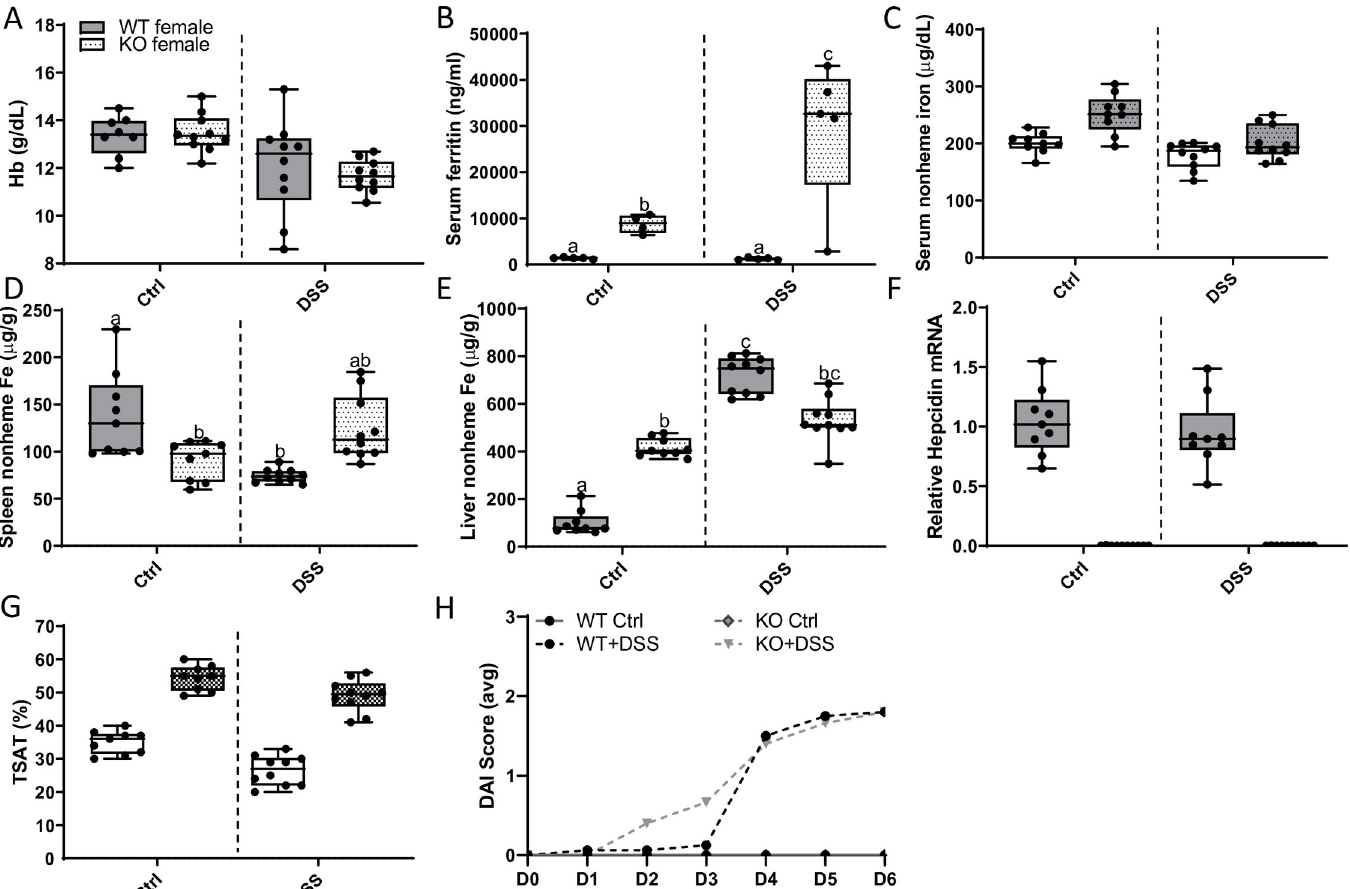
Fig 21. DSS treatment had differential effects on blood Hb levels and spleen and liver iron content in female WT versus Hamp KO rats. Blood hemoglobin ( A ) and serum ferritin ( B ) levels were determined at sacrifice. Serum ( C ), spleen ( D ), and liver ( E ) nonheme iron levels were assessed using standard methods. Liver Hamp expression was also quantified by qRT-PCR ( F ). TSAT was also assessed using routine methods ( G ). Data are presented as box plots for n = 8–10 rats/group and were analyzed by 2-way ANOVA followed by Tukey’s multiple comparisons post hoc test. Groups labeled with different letters vary significantly ( p < 0.05). Genotype × Treatment, p � 0.0134 ( B, D, E ); Genotype, p = 0.0080 ( B, D ); Treatment, p � 0.0147 ( A-C, E, G ). Disease activity index (DAI) scores were determined daily in water (control) and DSS-treated rats of both genotypes ( H ). Scores were averaged on each day for each group. Data were analyzed by repeated-measures 2-way ANOVA (Treatment main effect, p � 0.0004; KO Ctrl vs. KO + DSS, p < 0.0001; WT Ctrl vs. WT + DSS, p < 0.0001). No statistical differences were noted between genotypes.